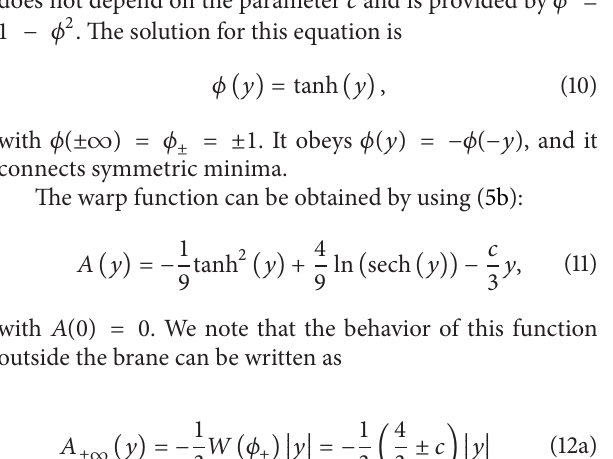
does not depend on the parameter 𝑐 and is provided by 𝜙 󸀠 = 1 − 𝜙 2 . The solution for this equation is